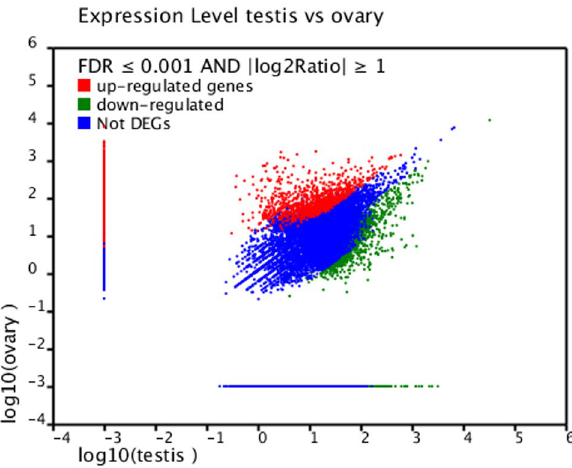
Figure 4. Scatter plots showing gene expression profiles in testis and ovary libraries of P.clarkii . Limits defined by FDR # 0.001 and |log 2 ratio| $ 1. Blue dots represent genes with similar expression in testis and ovary; red and green dots indicate up-regulated and down- regulated genes in ovary, respectively ( . 1.5-fold change, black diagonals).